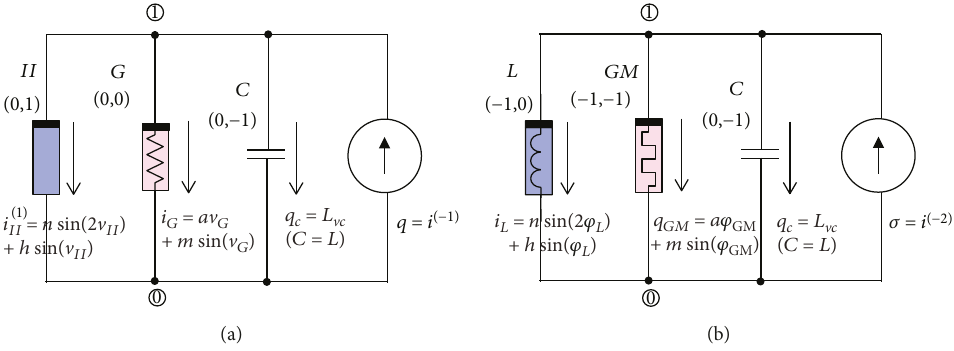
Figure 7: Circuit from Figure 4(d) and its dual circuit according to the “ shift-type ”